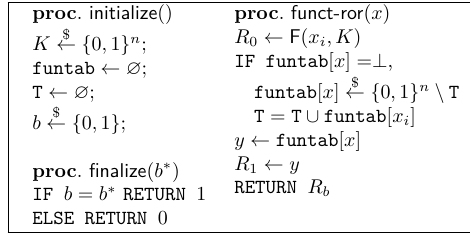
Figure 27: Procedures in Security Game